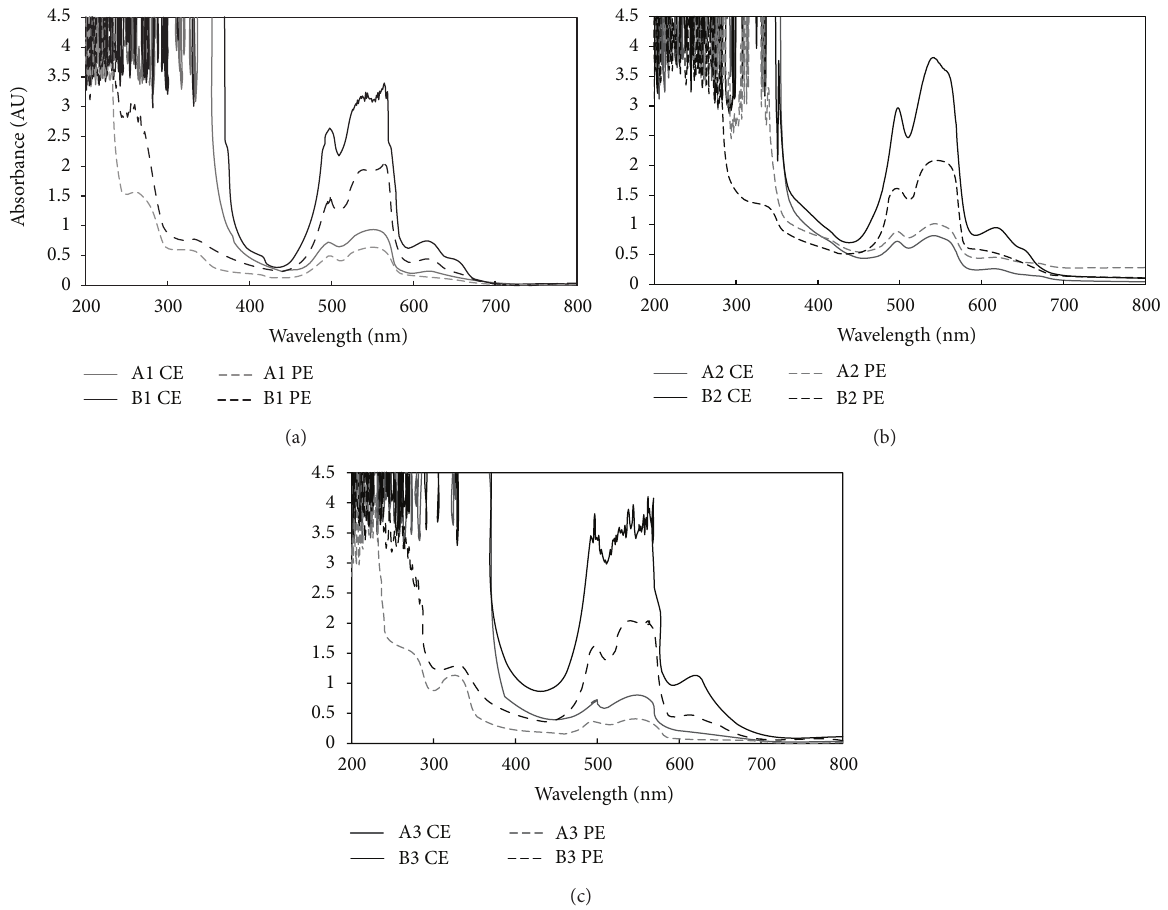
Figure 4: Grateloupia turuturu : absorbance spectra of the R-phycoerythrin crude extract (CE) and protein extract (PE). Comparison of storage methods for the three samples; (a): no storage (1) , (b): storage at room temperature, darkness, 6 months (2), and (c): storage at –20 ∘ C, darkness, 6 months (3), of the two field collection sites A (the gray solid line and the gray dashed line) and B (the black solid line and the black dashed